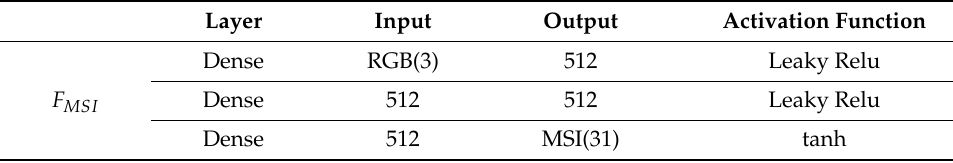
Table 2. The architecture of Generator F MSI .